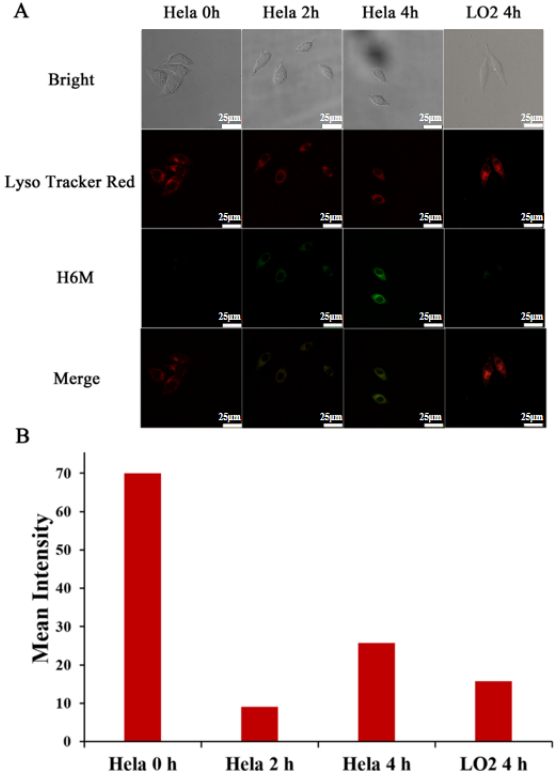
Figure 7. Intracellular fluorescence activation of H6M . ( A ) Confocal fluorescence images of HeLa and LO2 cells treated with H6M and LysoTracker red at different timepoints. Scale bar = 25 μ m. ( B ) Mean fluorescence intensity of H6M in HeLa and LO2 cells were quantified at selected timepoints after incubation.